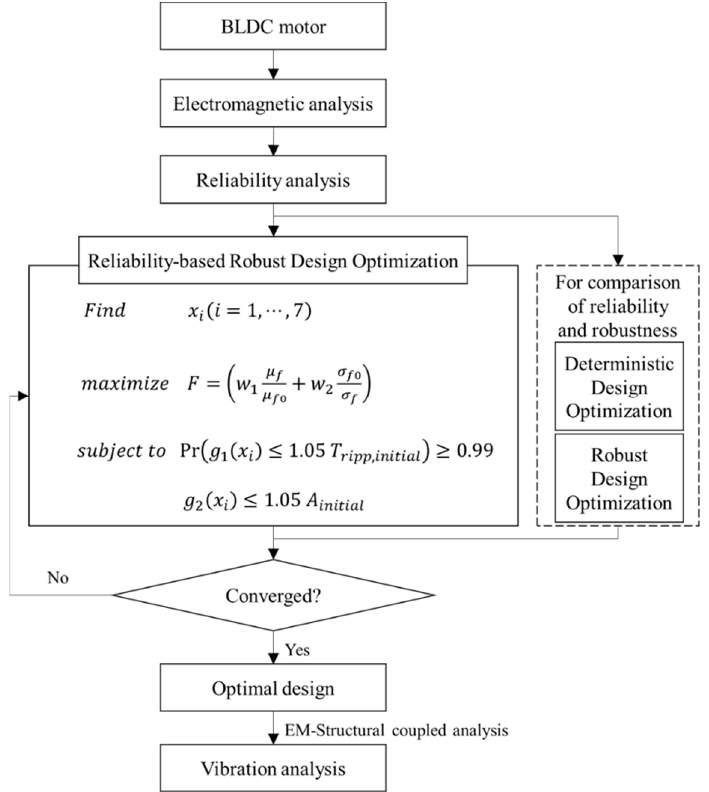
Figure 11. Flowchart of the RBRDO method.